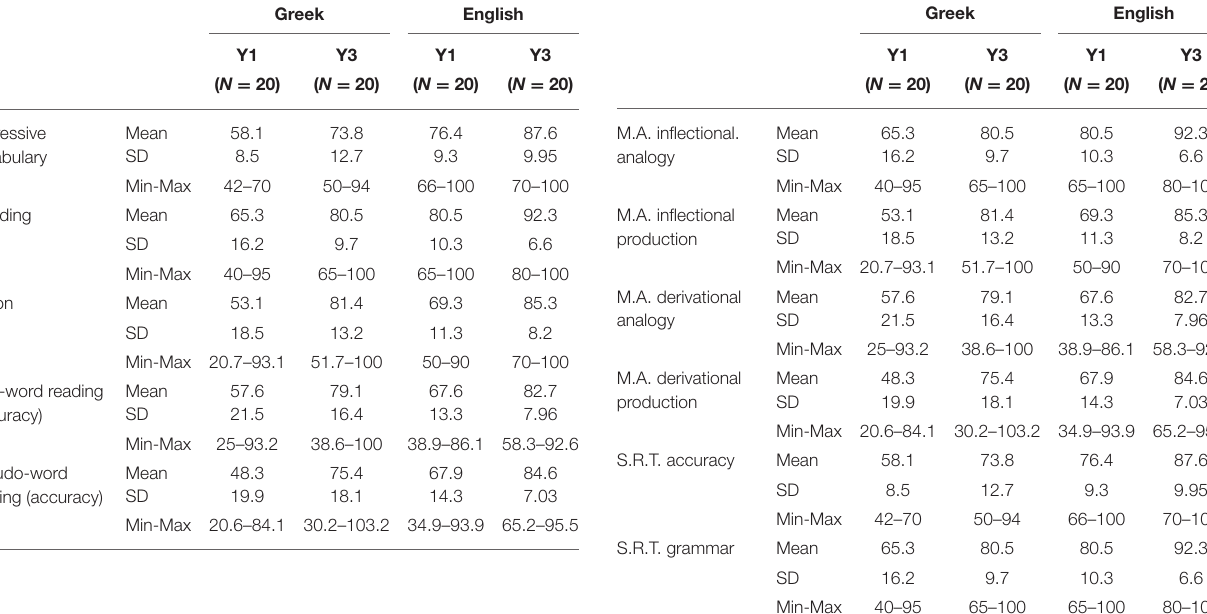
TABLE 4 | Descriptive statistics of the children’s performance on the Greek and English morphological awareness and sentence repetition (SRT) tasks (percentage correct). Greek